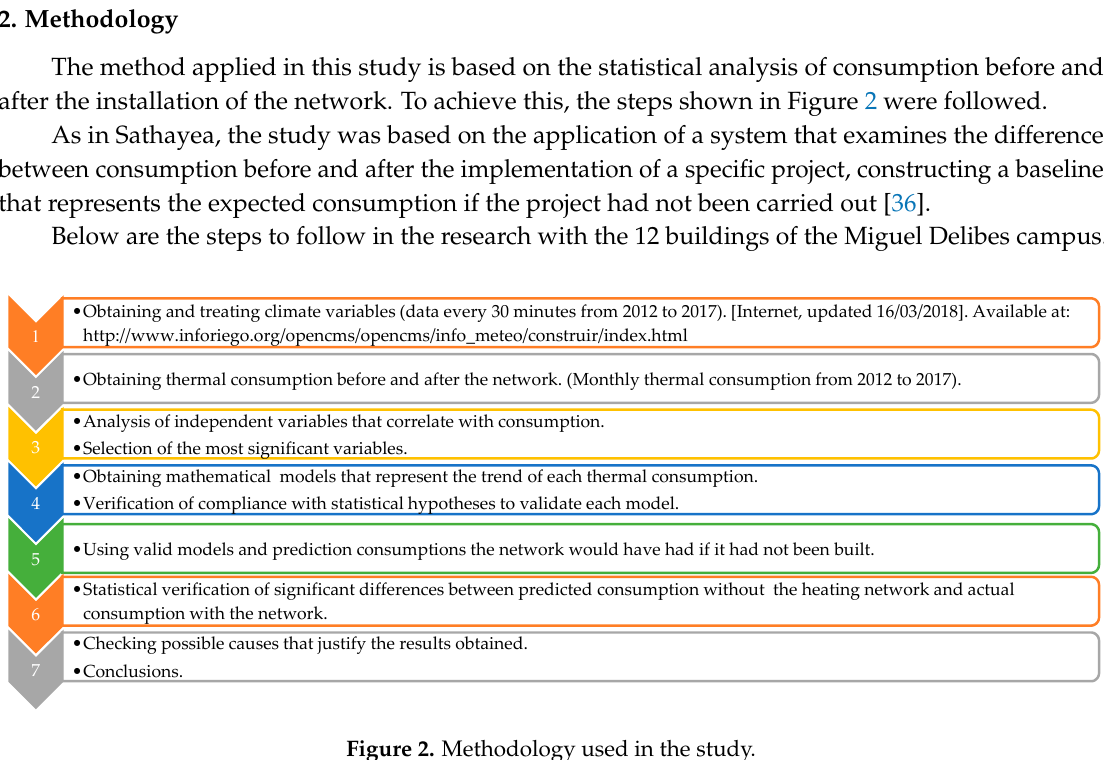
Figure 2. Methodology used in the study.